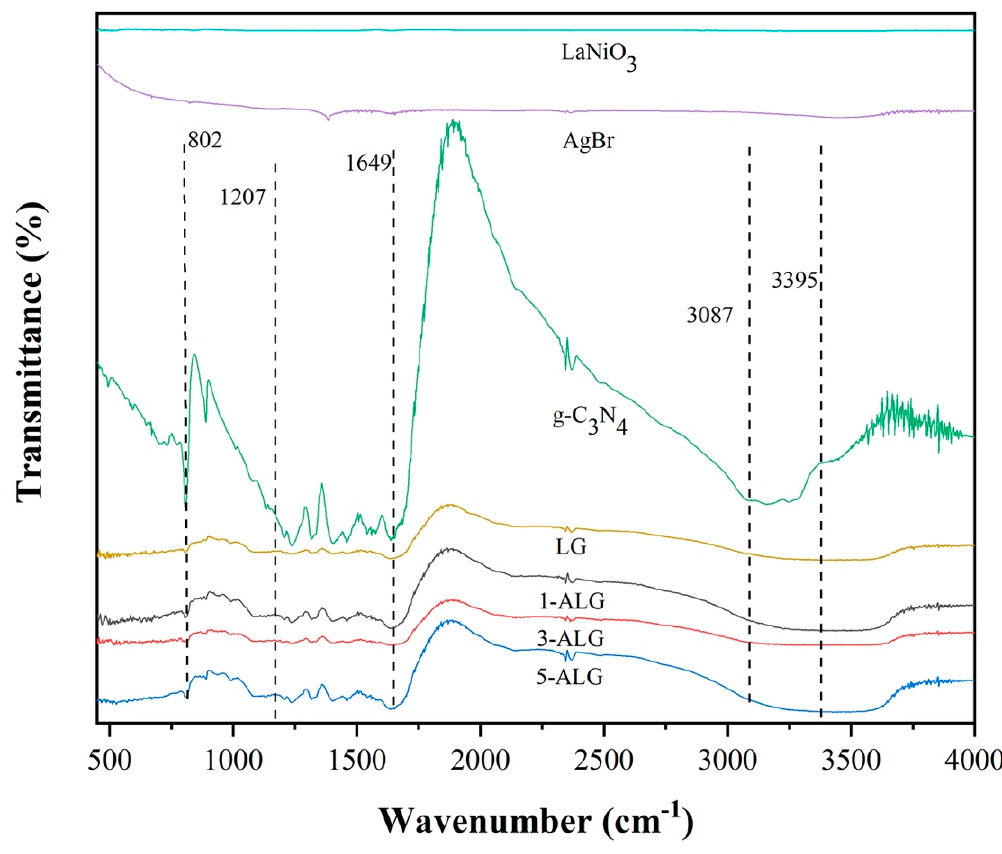
Figure 2. FT-IR spectra of bare AgBr, g-C 3 N 4 , 1-ALG, 3-ALG and 5-ALG.